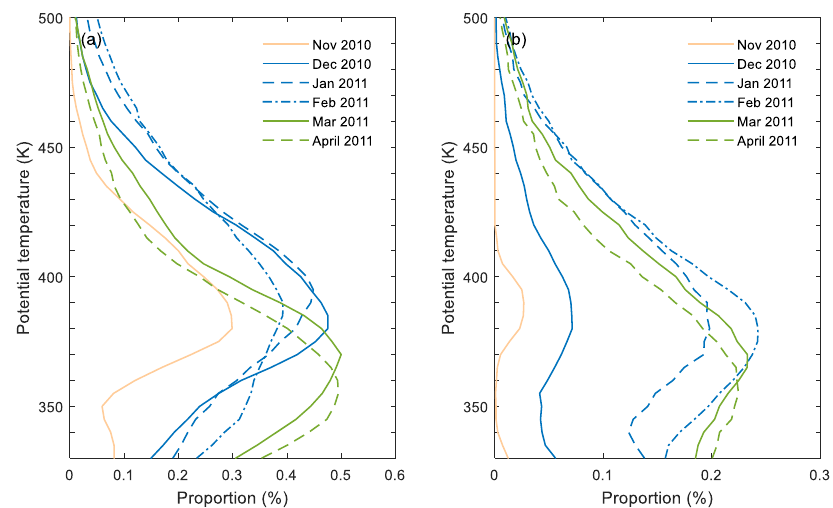
Figure 8. (a) Proportion (%) of the air parcels poleward of the PV-based transport boundaries at the end of each month; (b) proportion (%) of the air parcels south of the geographic latitude of 60 ◦